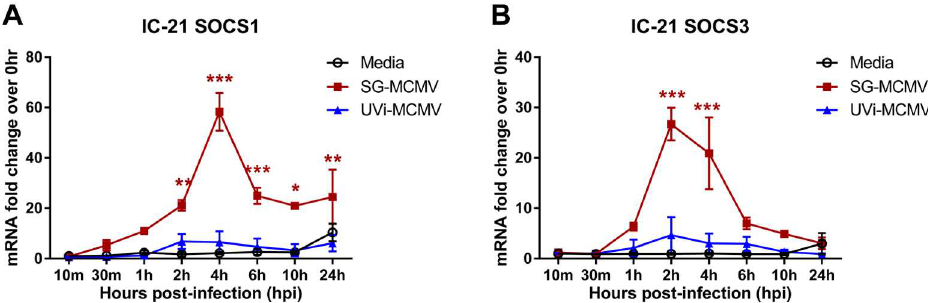
Fig 3. UV-inactivation of MCMV abrogates MCMV-related stimulation of SOCS1 and SOCS3 mRNA transcripts in mouse macrophages. IC-21 mouse macrophages treated with media (control), infected with SG-MCMV (MOI = 3 PFU/cell), or treated with an equal volume of UVi-MCMV were assessedfor SOCS1 mRNA (A) or SOCS3 mRNA (B) by real-time RT-PCR assay using the comparative 2 - ΔΔ Ct method, with all samples comparedback to the media group at 0 hpi. Means ± SD of at least duplicateexperimental repeats are shown. * p < 0.05, ** p < 0.01,and *** p < 0.001,comparedwith respective media controls at the same time points. No statistically significantdifferences were found betweenthe media controls and the UV-MCMV groupsat any time